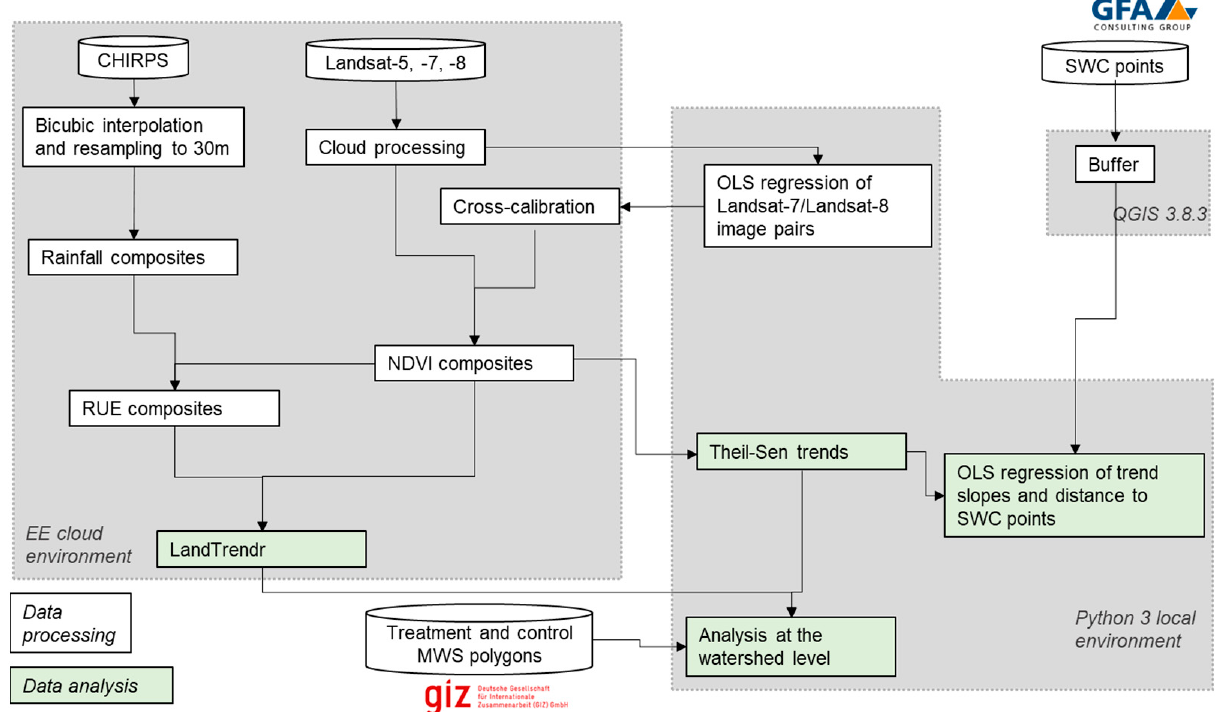
Figure 2. Workflow of the overall steps of the methodology.